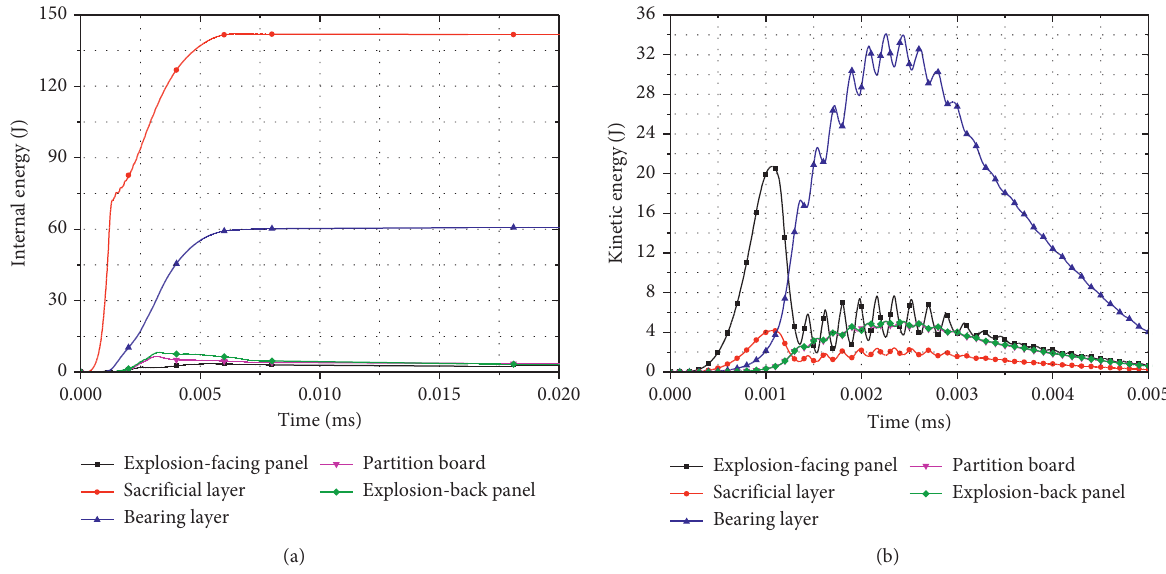
Figure 28: Energy time-history curve of ST4 in numerical simulation. (a) Internal energy time-history curve. (b) Kinetic energy time-history